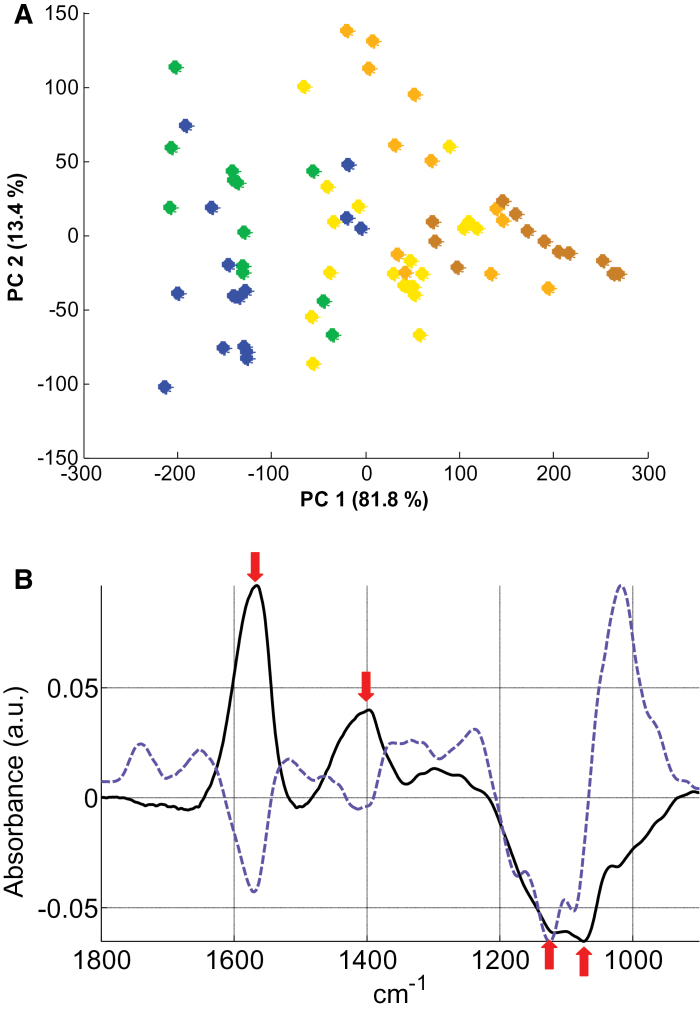
PCA analysis of FT-IR spectra obtained from all individuals in the C condition (5 μM CdSO4). (A) Each dot is the projection of one spectrum on the first and second PCs. Green dots, A. lyrata petraea; blue dots, A. halleri NM population I28; from light to dark orange, A. halleri M populations AU, PL22, and I16. (B) Loading factor plots for PC1 (black line) and PC2 (blue line) explaining PCA clustering. Arrows point to the discussed wave numbers. Note that the curve of PC2 has been offset for better readability.